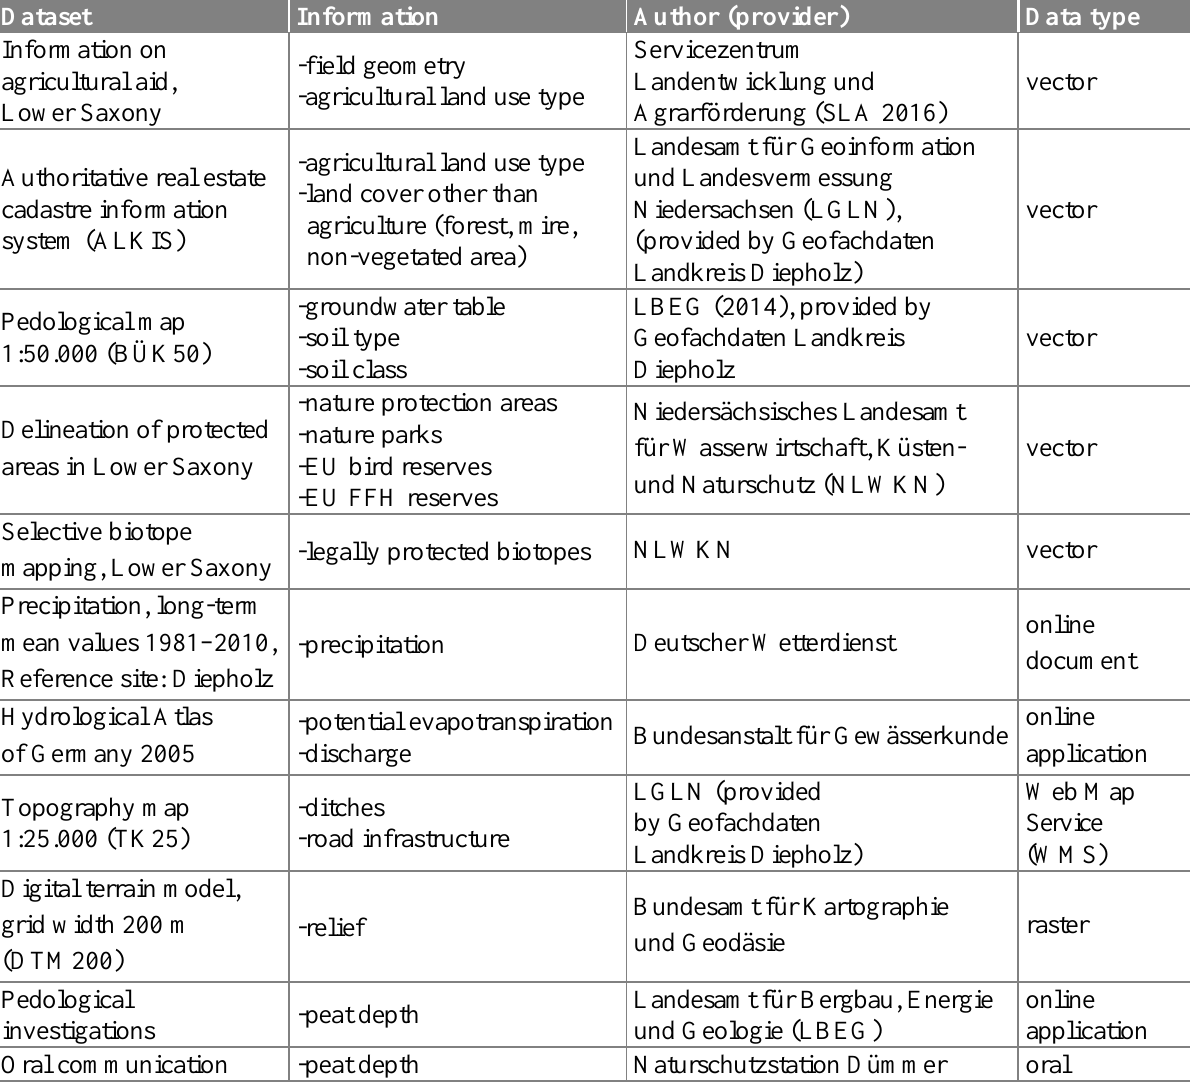
Table 1. Datasets used for application of the assessment tool to the study areas Lange Lohe – Boller Moor and